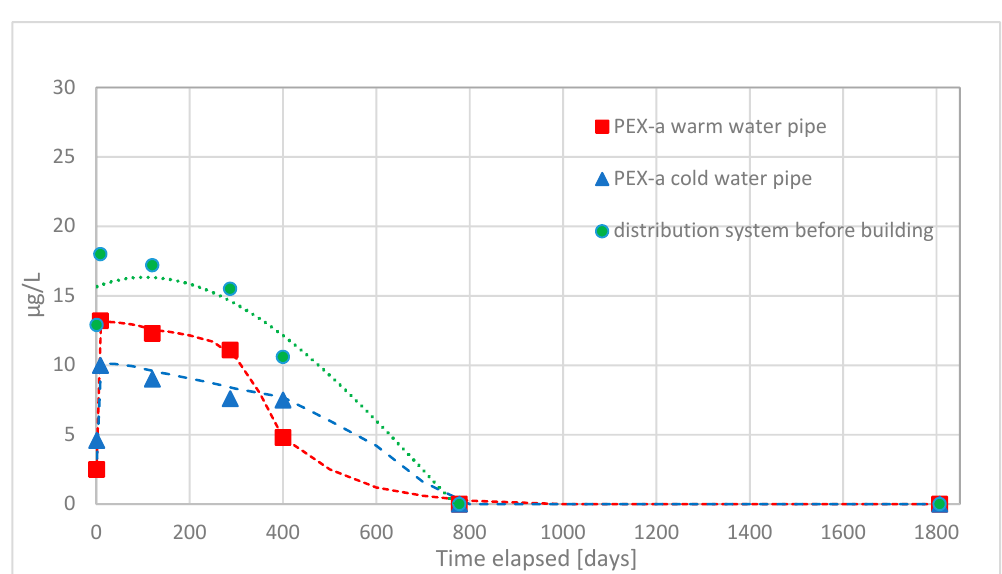
Figure 4. The observed concentrations of migrated ethyl tert-butyl ether (ETBE) during the first five years of use of the office building, from the PEX-a water pipes into the drinking water and their corresponding concentration in the water entering the building from the waterworks distribution system.